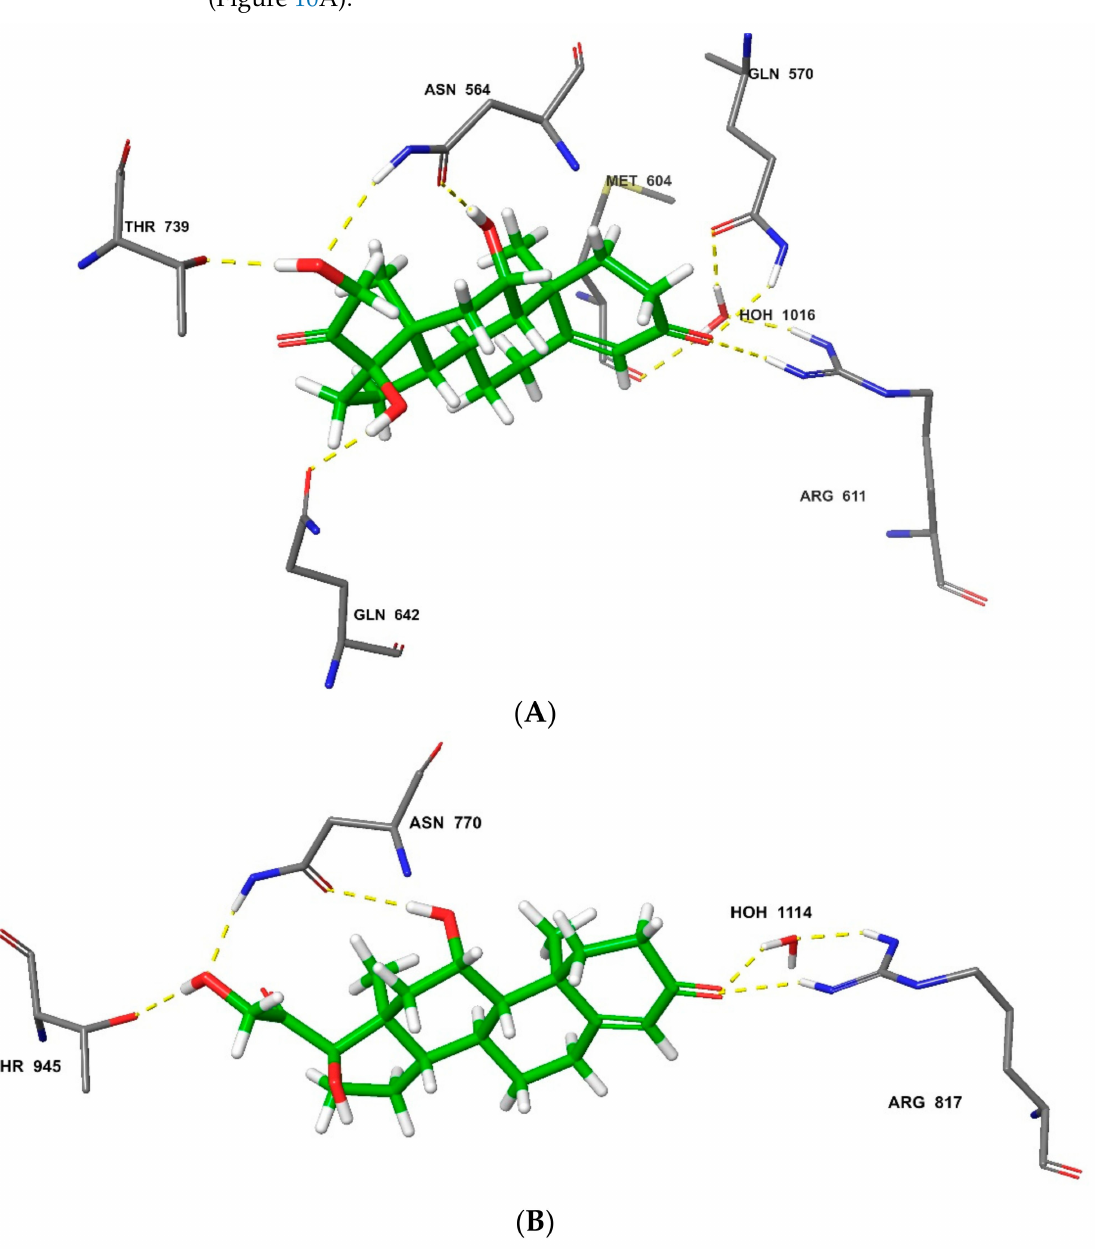
Figure 10. Molecular interactions in MM-GBSA re-docking of HCT against the glucocorticoid receptor with ( A ) MM-GBSA binding score: − 79.38 kcal/mol; and mineralocorticoid receptor with ( B ) MM- GBSA binding score: − 66.07